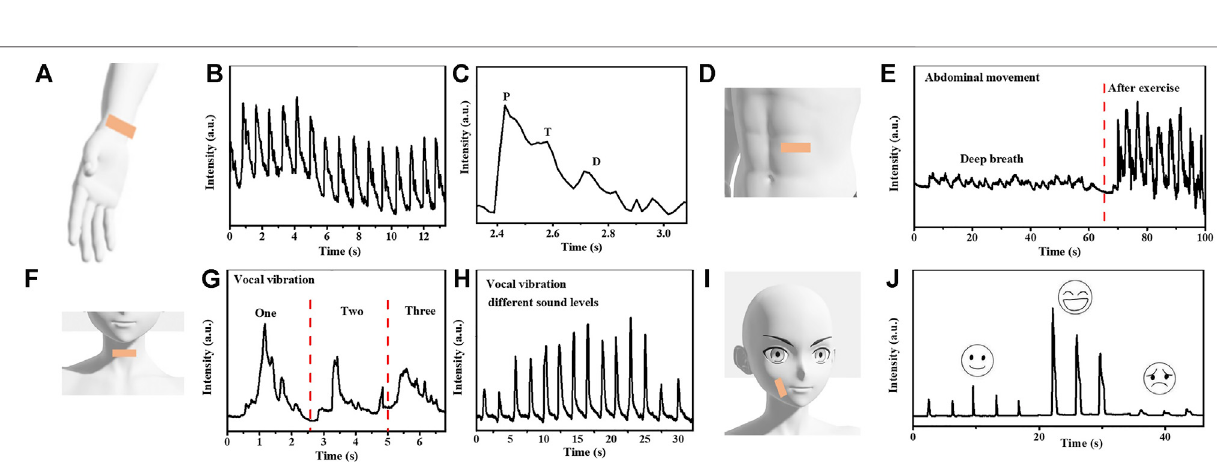
Frontiers in Sensors |